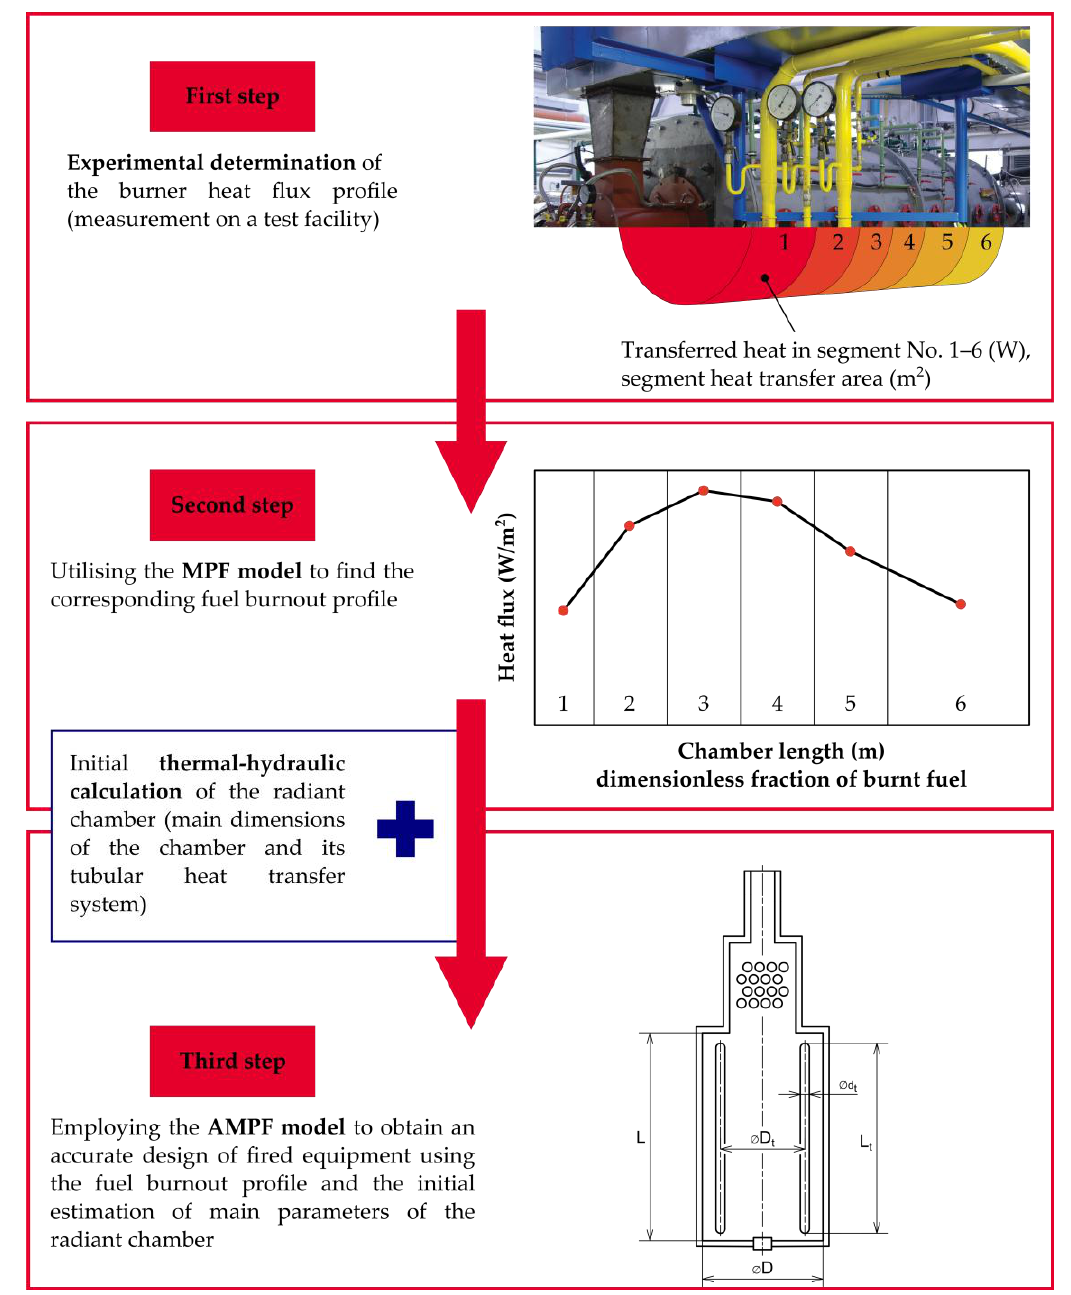
Figure 5. Schematic flow chart of the three-step modelling system for an accurate and reliable design of fired equipment